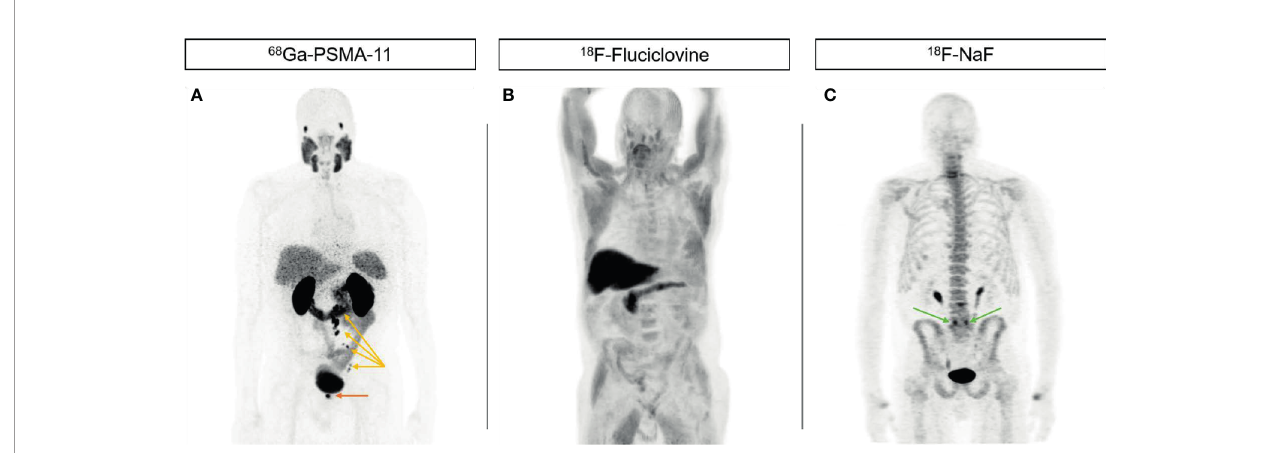
FIGURE 1 | Increased sensitivity of PSMA-targeted imaging compared to current alternatives. 71-year-old male presented initially with T3 N0 M0 Gleason 4 + 5 = 9 PSA 9.42 prostate adenocarcinoma who declined local therapy and was managed with ADT alone, subsequently with castration-resistant progression. (A) 68 Ga- PSMA-11 PET showing focal uptake in the right prostate bed (orange arrow) as well as left pelvic and retroperitoneal nodes (yellow arrows). (B) 18 F-Fluciclovine PET do not show any abnormal uptake. (C) 18 F-NaF PET do not show any abnormal uptake suspicious for metastases. Uptake at L5/S1 facets is due to degenerative change (green